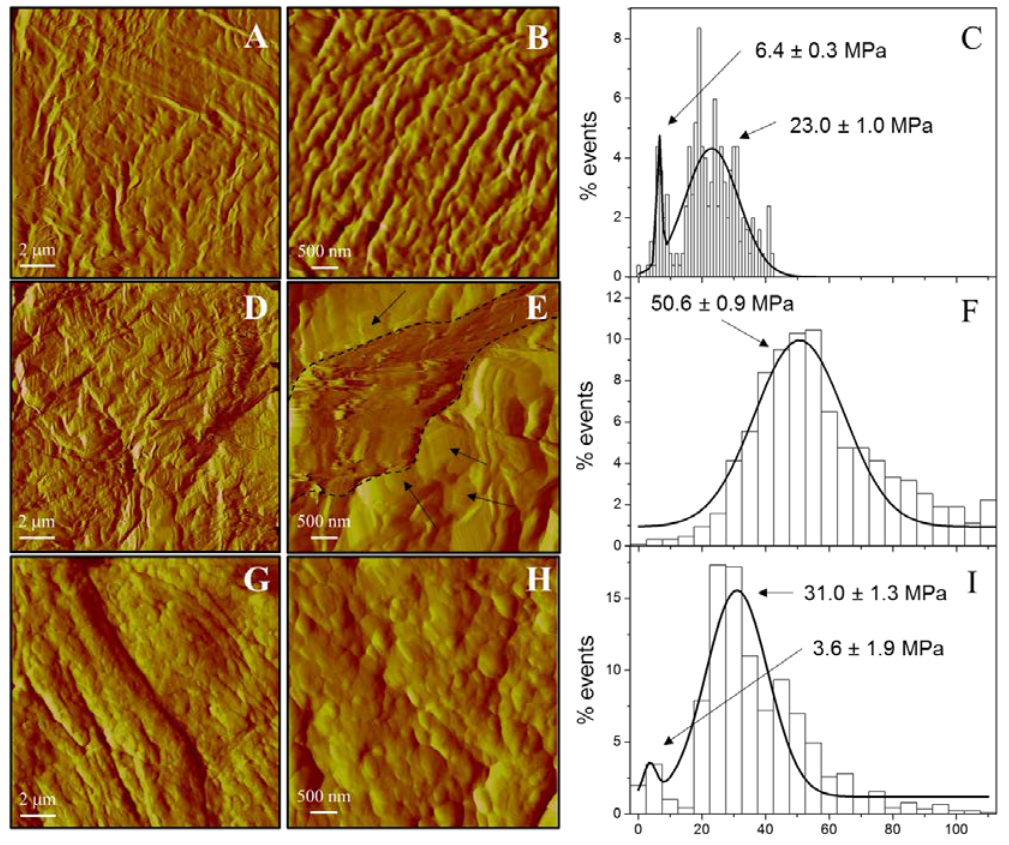
Figure 5. Atomic Force Microscopy ( AFM) deflection error images and Young’s modulus distribution for: control skin ( A–C ); skin treated with oxazolone ( D–F ); and skin treated with PGZ-NE ( G–I ). The continuous lines in Young’s modulus distribution represent the fitting of the experimental data to normal distributions.